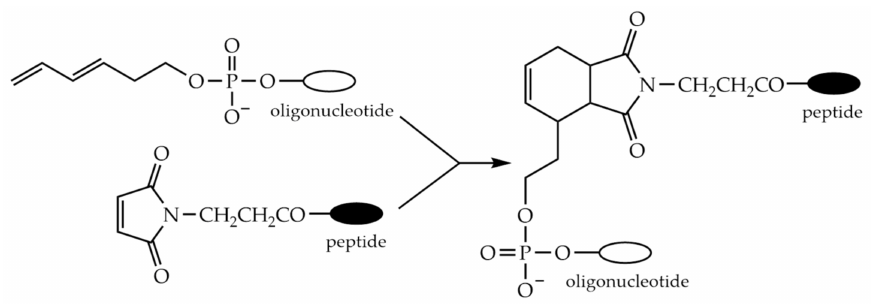
Figure 18. Conjugation through Diels-Alder